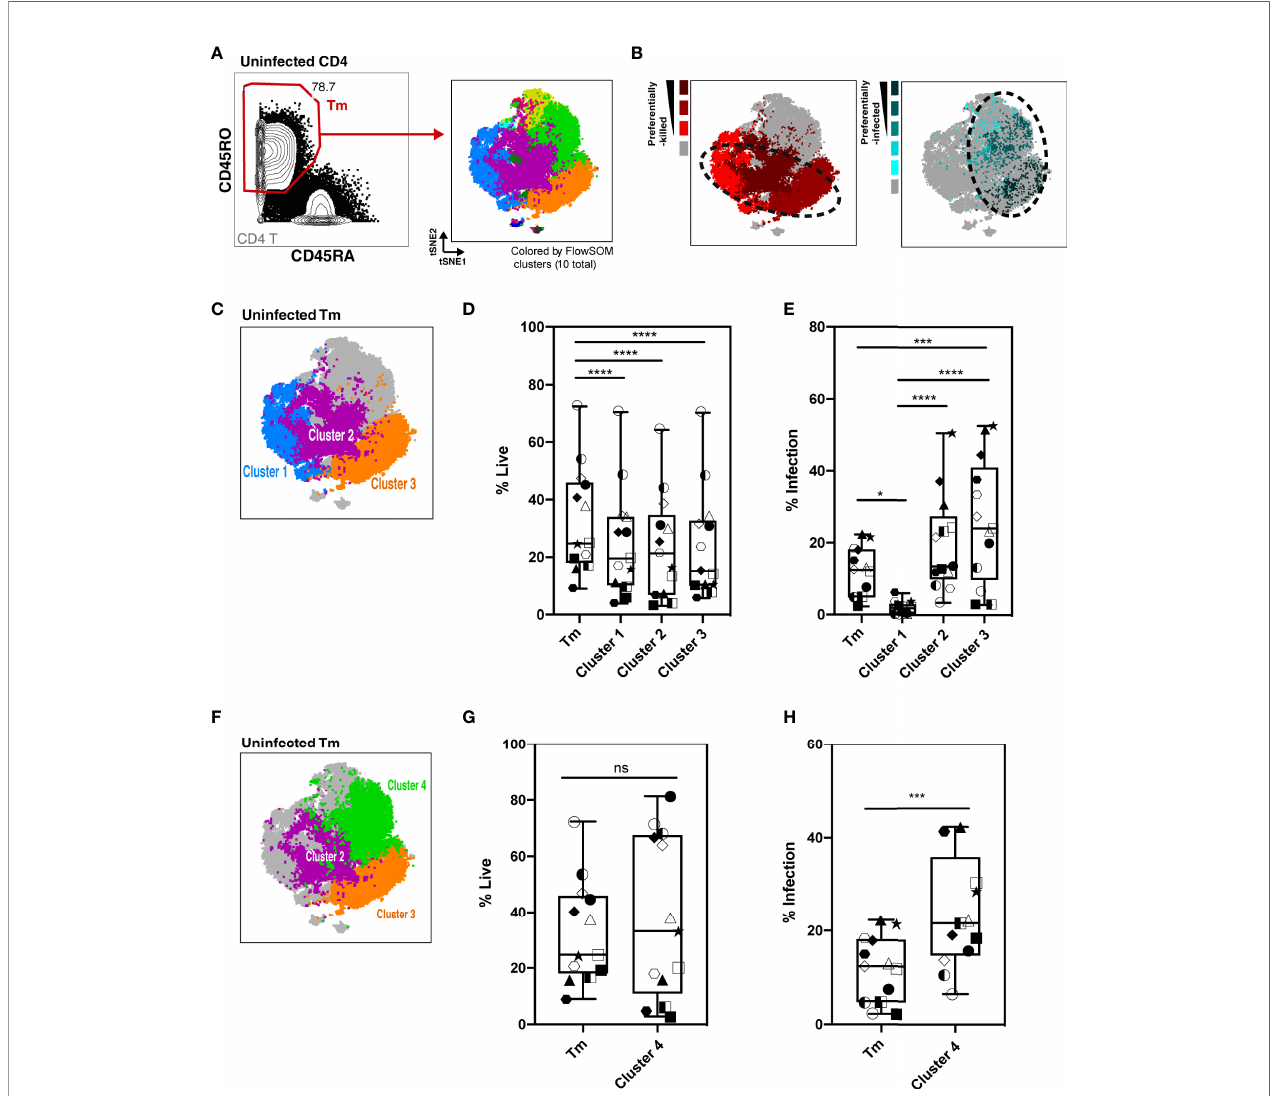
FIGURE 4 | Characterization of HIV-associated killing and infection inFlowSOM-de fi ned Tmsubsets. (A) Visualization of HLAC Tmcell clustersby FlowSOM, an algorithm based on a self-organizingmap. Leftpanel: Example of Tm gating strategy(CD45RO+CD45RA-) (left). Right panel: Exampleof a tSNE plot colored byFlowSOM clusters(10 total).Precedingparent gates are indicated at the lower leftcorner. Numberscorrespondto percentages for each gate. (B) Leftpanel: Preferentially-killed clusterscolored in different shades of red (darker red represents a higher level of killing). Right panel: Preferentially-infected clusterscolored indifferent shades of aqua (darker aqua represents a higher infection rate).Other clusterswere colored ingray. Dottedcircles on the tSNE plot shows that the preferentially-killed (left) and preferentially-infected (right) subsets do not completely overlap phenotypically. (C) Location of three preferentially-killedsubsets shownon a tSNE plot: cluster 1 (blue),cluster 2 (purple), and cluster 3 (orange).Other clusters were colored as gray. (D,E) Proportion of live cells (D) and infection rate (E) of each ofthe 3 preferentially-killed subsets from 6 donors, plotted as box plots. Symbolsrepresents technical repeats from 6 donors. Each donor isrepresented as a shapewith technicalrepeats represented with different type of fi ll(detailsdescribed in Materials andMethods). ***p ≤ 0.001; ****p ≤ 0.0001; nolabel: not signi fi cant, p > 0.05. Signi fi cance was measured byone-way ANOVA with repeated measurements followedby post-hoc tests for multiplecomparisons correction.(n= totalpaired-wise comparisons). (F) Location ofthe three preferentially-infectedsubsets ofTmcells on the tSNE plot: cluster 2 (purple),cluster 3 (orange) and cluster 4 (green). Other Tm clustersare colored as gray.Tm( G,H) Proportion of live cells (G) and infection rate (H) inTm andin cluster 4 from6 donors, plottedas box plots. Symbolsrepresents technical repeats from6 donors. Each donor isrepresented as a shapewith technical repeats representedwith different typeof fi ll(details described inMaterialsand Methods). ***p ≤ 0.001; n.s.,not signi fi cant, p > 0.05. Signi fi cance was measured bypaired Student ’ s T test. Paired effect between Tm andeach of the 4 clusters was shownbyestimation plots in Figure S9